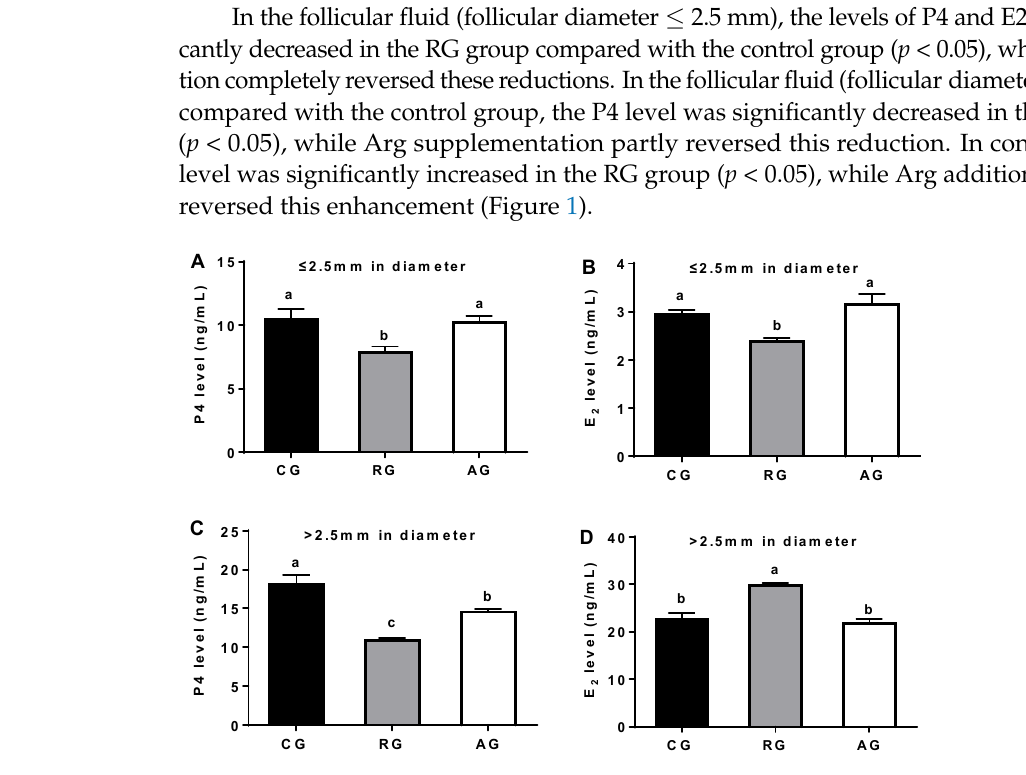
Figure 1. Effects of diet and arginine on sex hormone levels in follicular fluid of ewes. ( A ): P4 level in follicular fluid (follicular diameter ≤ 2.5 mm); ( B ): E 2 level in follicular fluid (follicular diameter ≤ 2.5 mm); ( C ): P4 level in follicular fluid (follicular diameter > 2.5 mm); ( D ): E 2 level in follicular fluid (follicular diameter > 2.5 mm). Abbreviations: CG, control group; RG, restriction group; AG, Arg group; P4, progesterone; E 2 , estradiol. Values are means ± SE (n = 6). Columns with different superscripts differ significantly among any groups ( p <